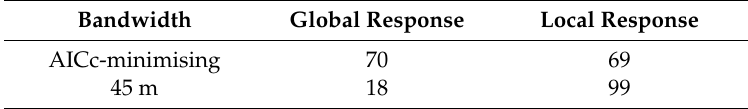
Table 5. Percentage of 500 simulations in which the correct model was identified by a Monte Carlo test for spatial